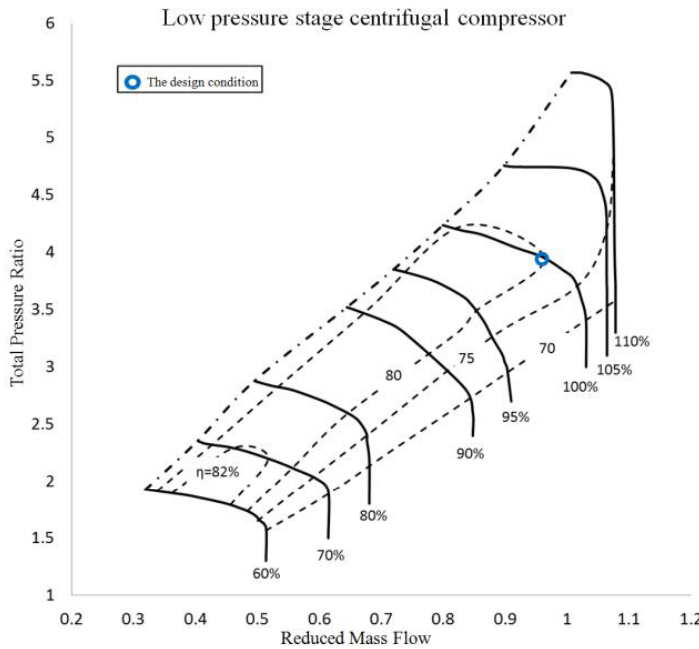
Figure 5. Performance curve of the low-pressure-stage centrifugal compressor.